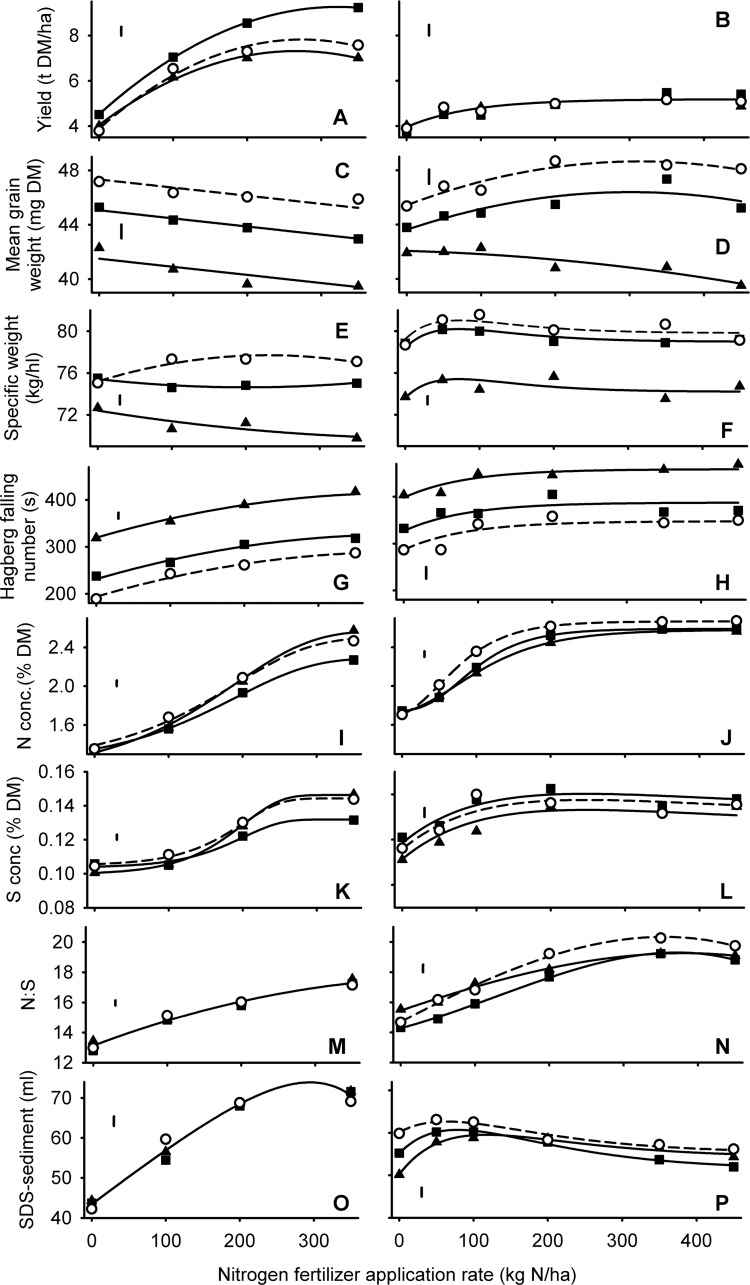
Rht allele and nitrogen effects on yield and quality of wheat.Allele at the Rht-B1 locus denoted: ○, dashed line = tall; ▲ = -B1b; ● = -B1c. Error bars are one standard error of difference (D.F. > 50) for comparing alleles at the same N level. Left and right panels are for grain harvested in 2010 and 2011 respectively.